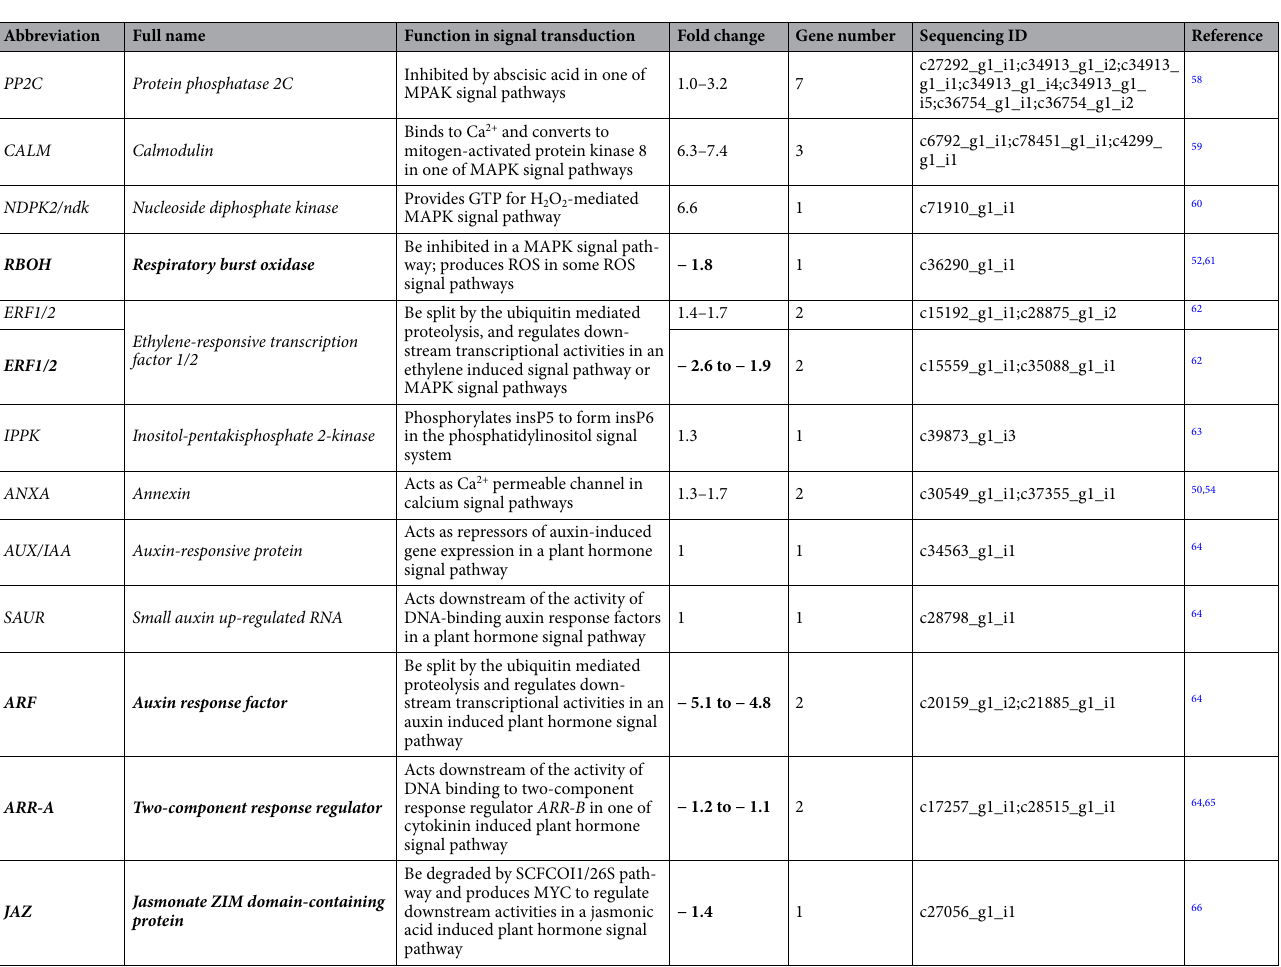
Table 2. Information of differentially expressed genes involved in signal transduction. Negative values are in